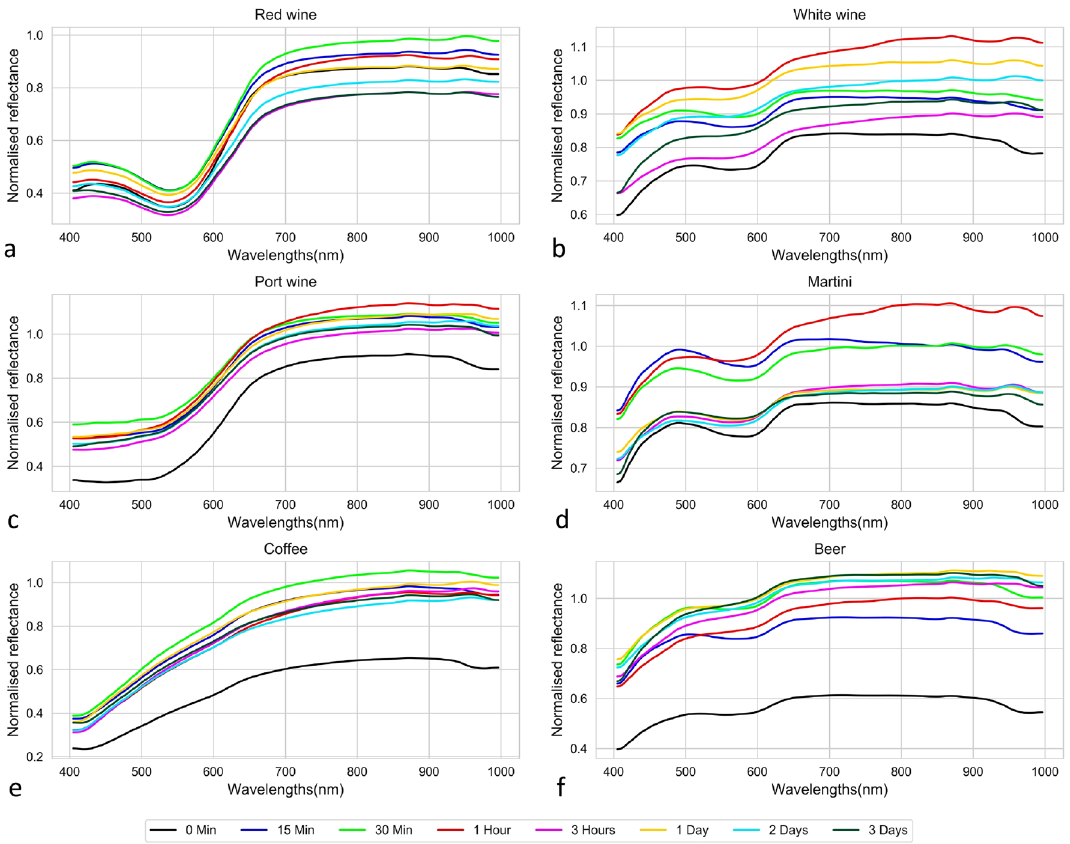
Figure 6. Spectral reflectance changes of beverage stains over time